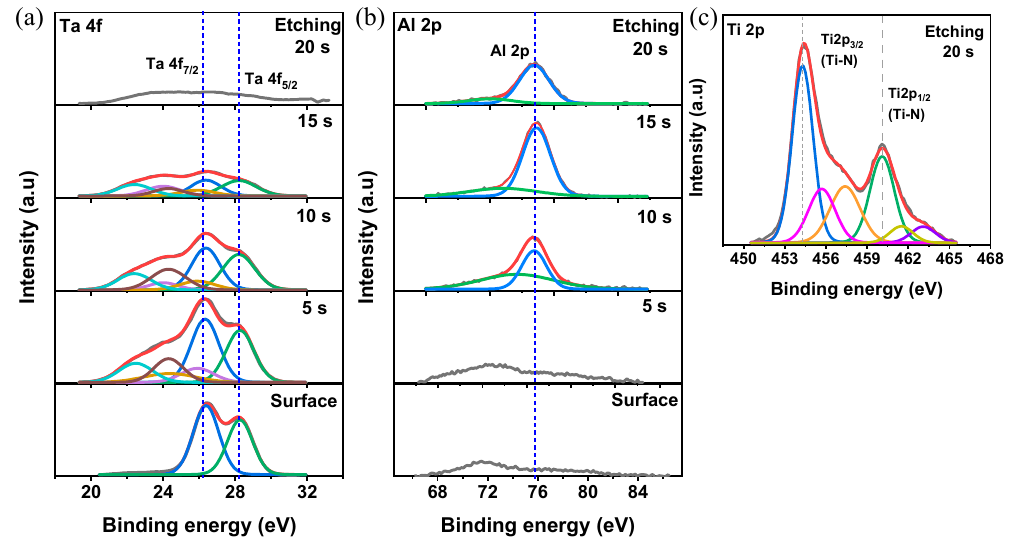
Figure 2. XPS analysis by Ar + etching of Ta 2 O 5 /Al 2 O 3 /TiN layer: ( a ) Ta 4f spectra of the Ta 2 O 5 film; ( b ) Al 2p spectra of the Al 2 O 3 film; ( c ) Ti 2p spectra of the TiN bottom electrode.